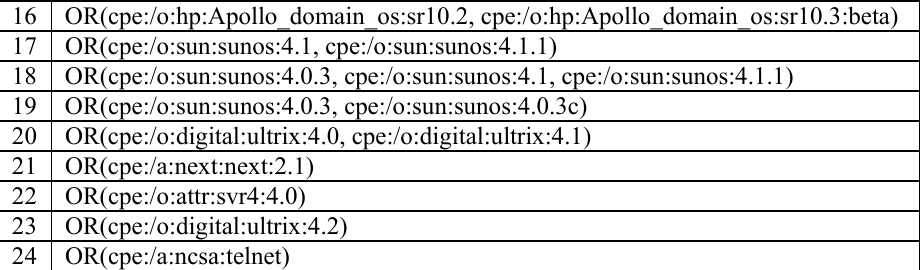
Figure 3. Example of vulnerability representation as a row in a